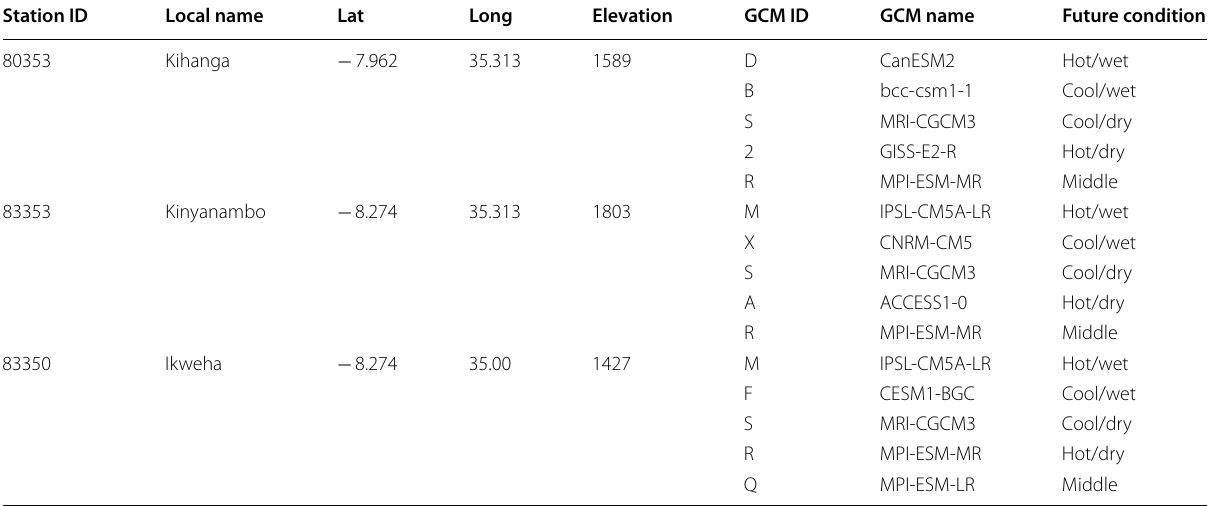
Table 3 Selected CMIP5-GCMs for forcing the SWAT model Station ID